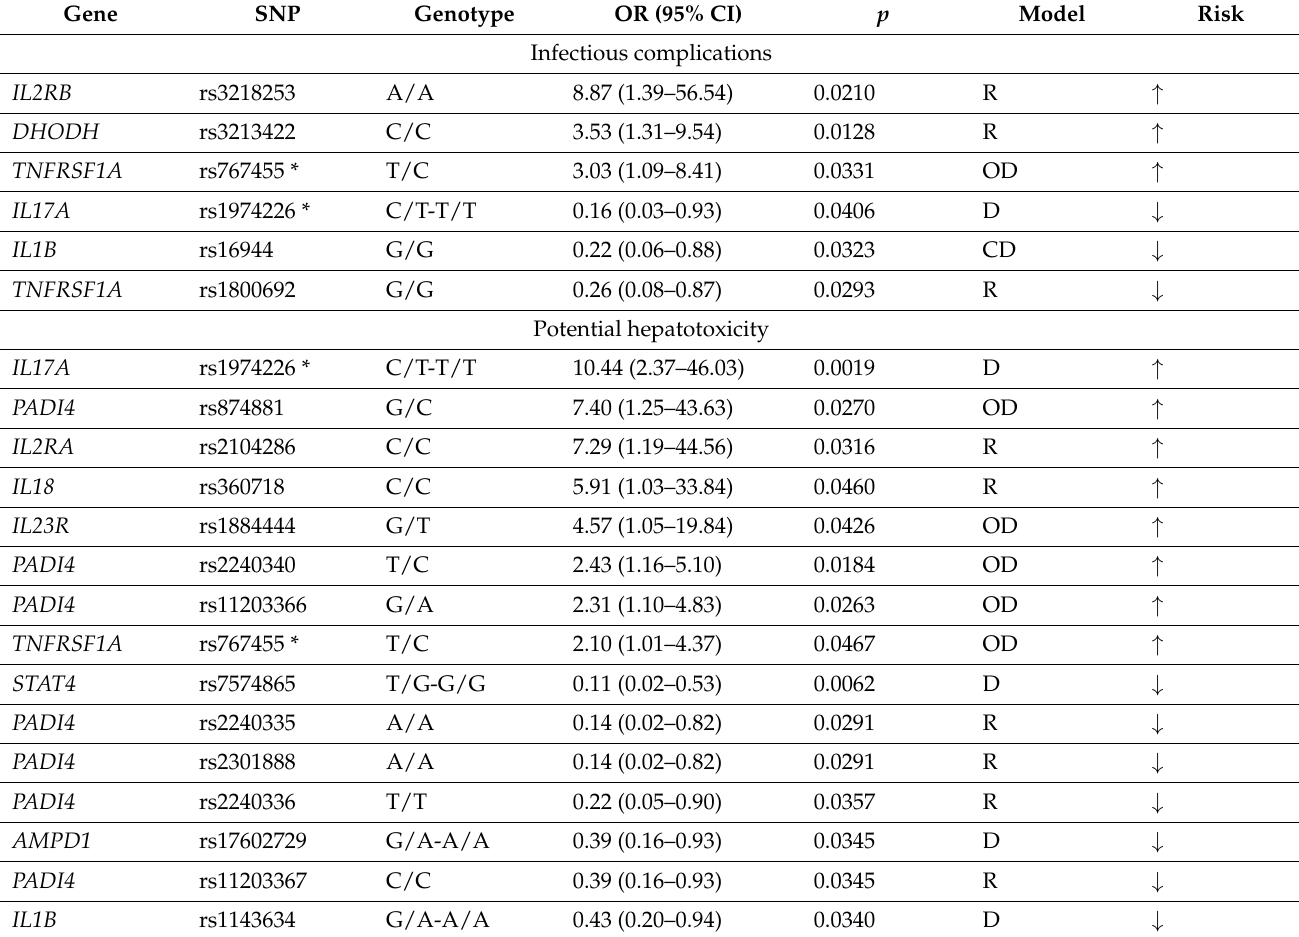
Table 3. Associations of polymorphic variants with the safety of